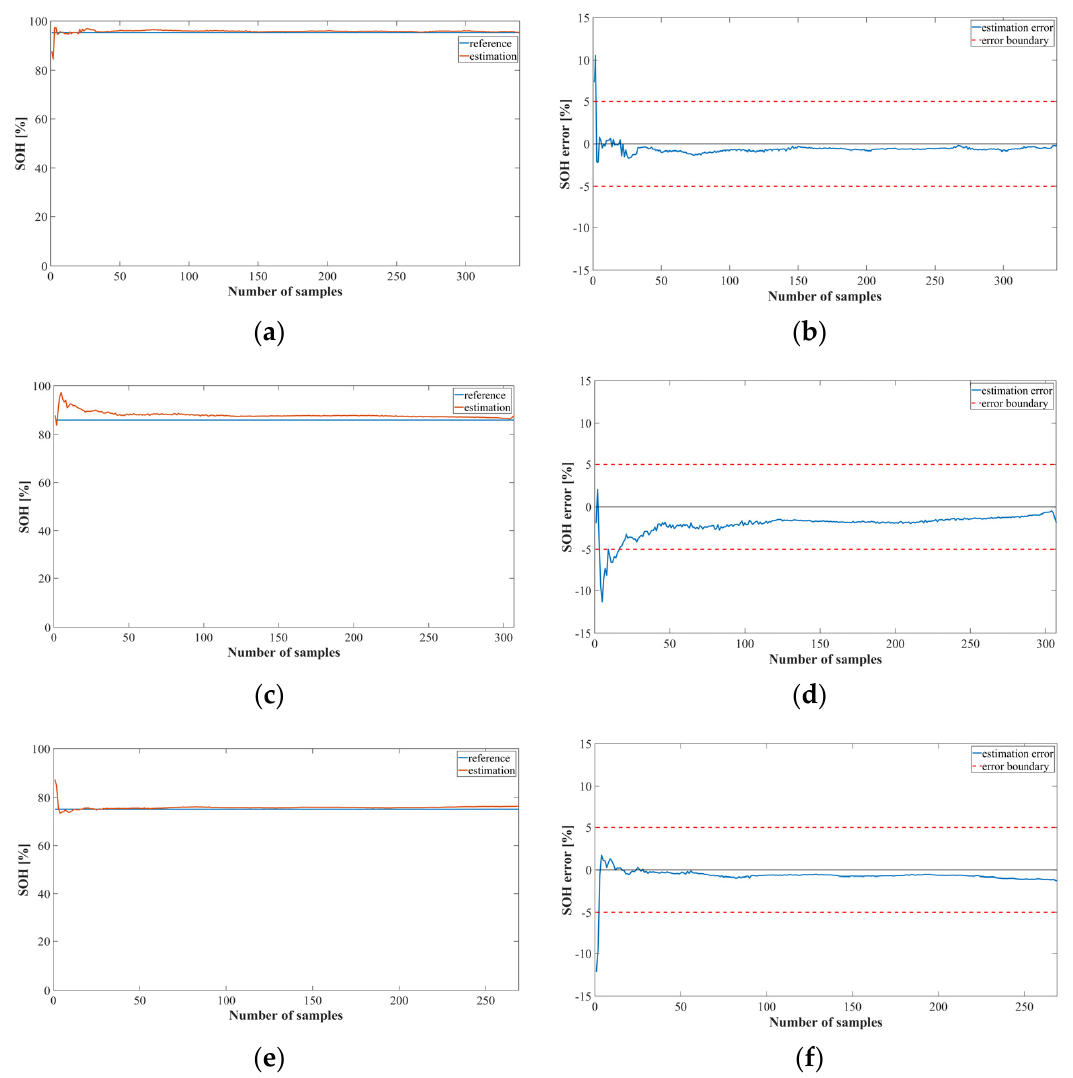
Figure 11. SOH estimation results for Method 2 using the MNN (NASA dataset): ( a ) SOH estimation result; ( b ) error at cycle 41; ( c ) SOH estimation result; ( d ) error at cycle 78; ( e ) SOH estimation result; ( f ) error at cycle 125. Table 4. SOC estimation error for each model using the Oxford battery